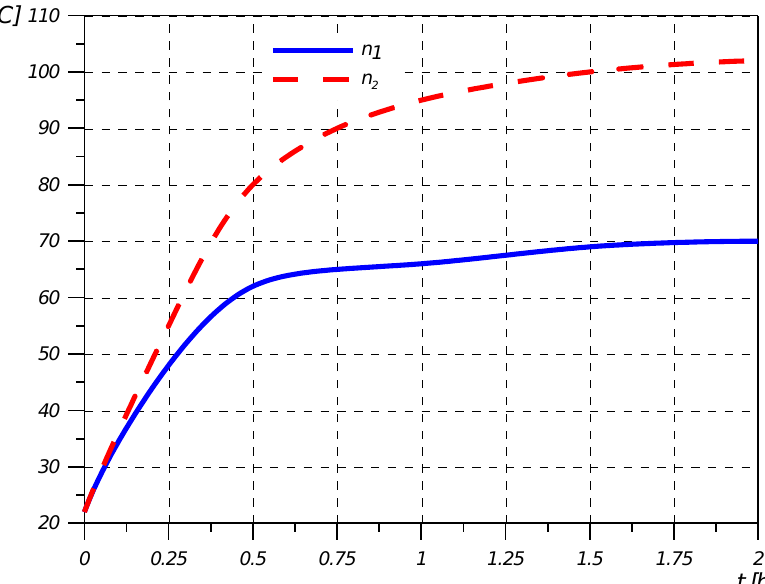
Figure 10. Damper temperature changes as a function of time for different shaft rotational speeds n i (n 1 < n 2 ).